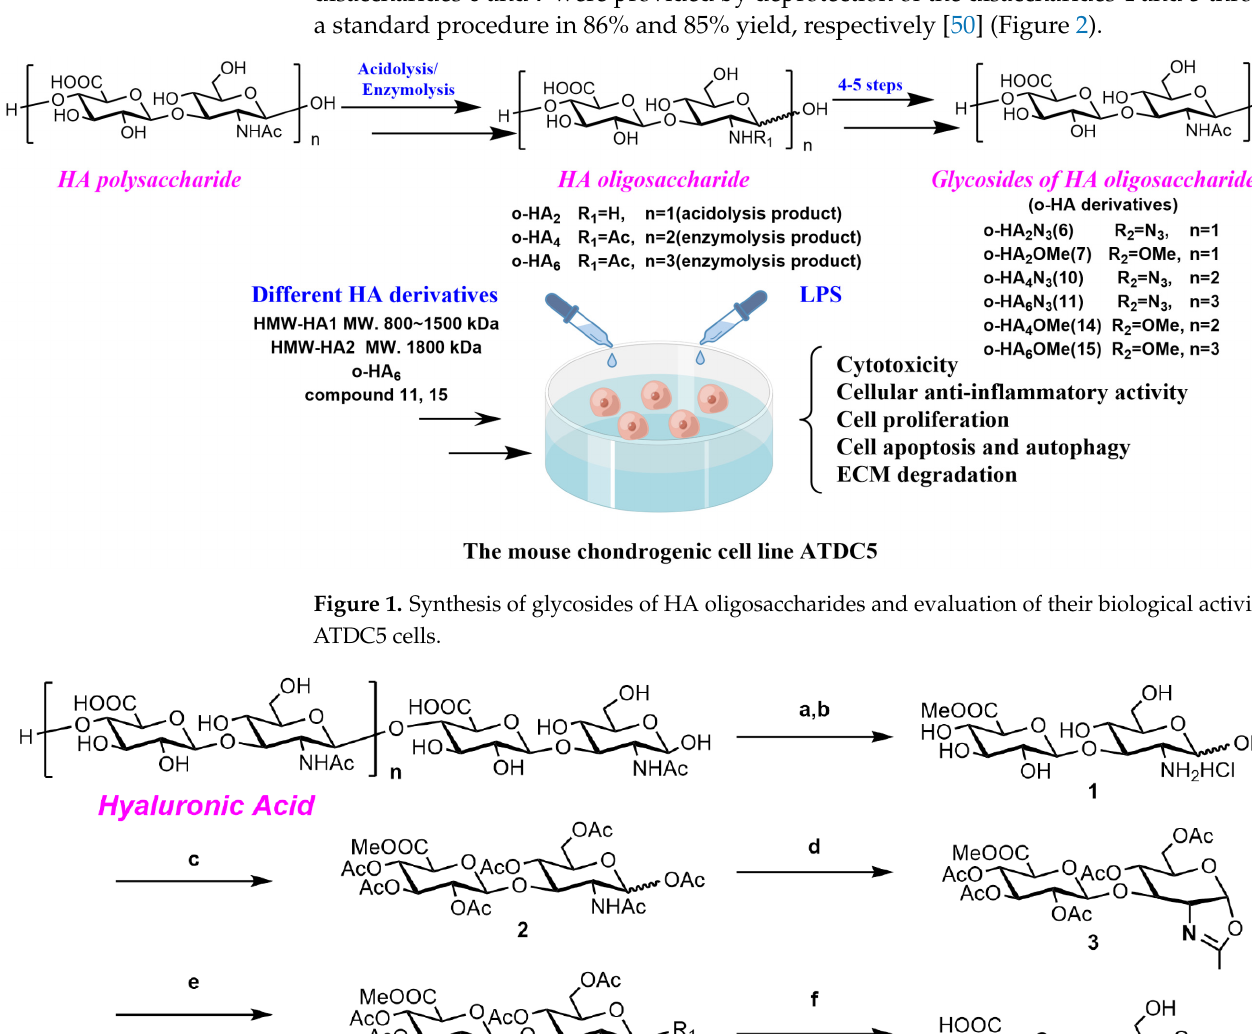
Figure 2. Synthesis of o-HA 2 OMe ( 6 ) and o-HA 2 N 3 ( 7 ). Reagents and conditions: ( a ) 0.5 M HCl, 80 °C, 2 d; ( b ) 0.06 M HCl, MeOH, 4 °C, 4 d; ( c ) Ac 2 O, Et 3 N, DMAP, DCM, 2 h, α / β = 2.5/1, 31% for 3